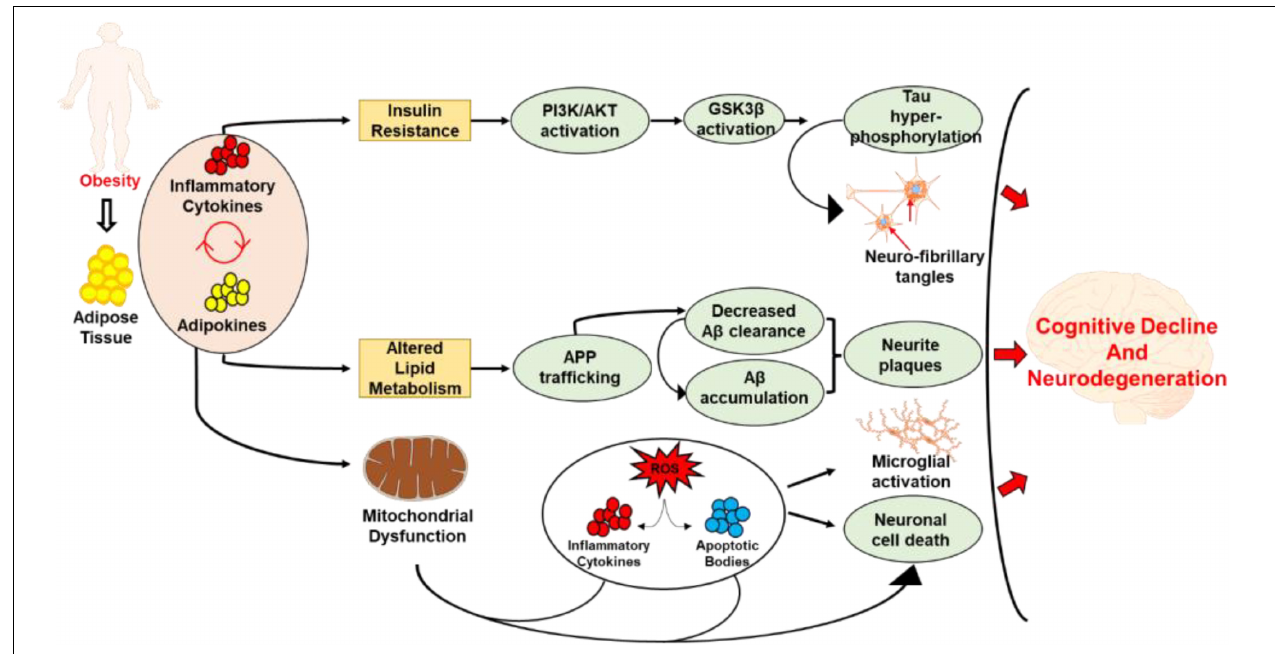
FIGURE 1 | Schematic representation demonstrating the mechanisms related to obesity associated cognitive decline and neurodegeneration. The excess accumulation of adipose tissue and the resulting release of adipokines and inflammatory cytokines leads to insulin resistance, altered lipid metabolism, and mitochondrial dysfunction. While the insulin resistance leads to tau hyperphosphorylation and development of neurofibrillary tangles, altered lipid metabolism caused A β accumulation, and development of neurite plaques. On the other hand, mitochondrial dysfunction causes excessive production of ROS, inflammatory cytokines and apoptotic bodies which lead to neural cell death. The inflammation resulting from mitochondrial dysfunction also leads to microglial activation. Collectively, these processes lead to cognitive decline and the development and progression of neurodegenerative disorders.